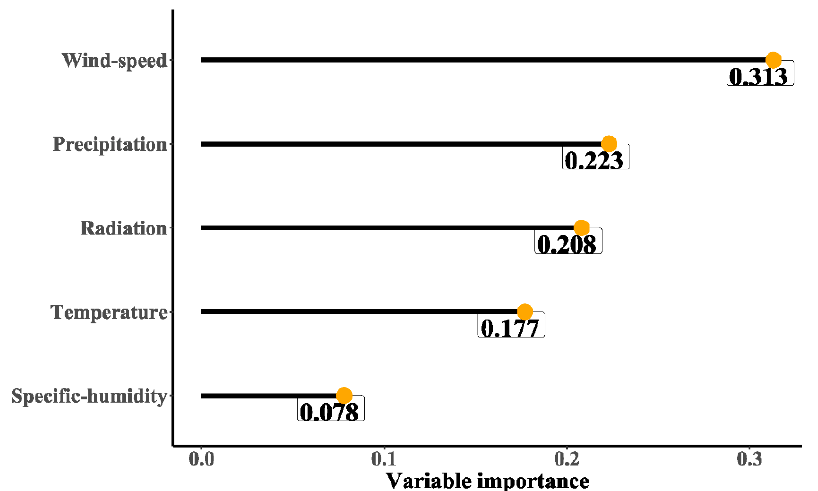
Figure 8. Random forest variable importance rankings. A higher value indicates the importance of that climate factor in lake change. Removal of that factor causes the model to lose accuracy in prediction.